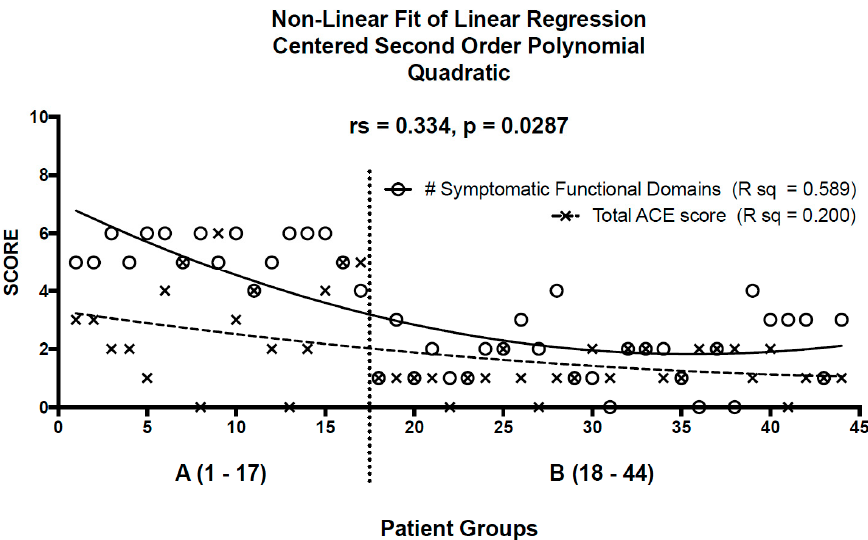
Figure 1. Non-linear fit of linear regression using a centered, second-order polynomial quadratic equation gives rise to lines of best fit for patients in Group A ( ≥ 4 medically unexplained symptoms; n = 17) and Group B (<4 medically unexplained symptoms; n = 27) for the number of symptomatic functional domains (r s = 0.589) and total ACE score (r s = 0.20). There is a moderate and statistically significant correlation between the number of symptomatic functional domains and total ACE score for all patients (r s = 0.334, p = 0.0287).